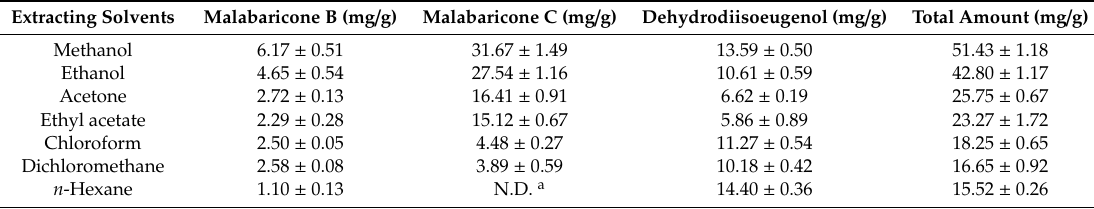
Table 4. Identification and quantification of the major active components from Myristica fragrans in di ff erent solvent extracts.